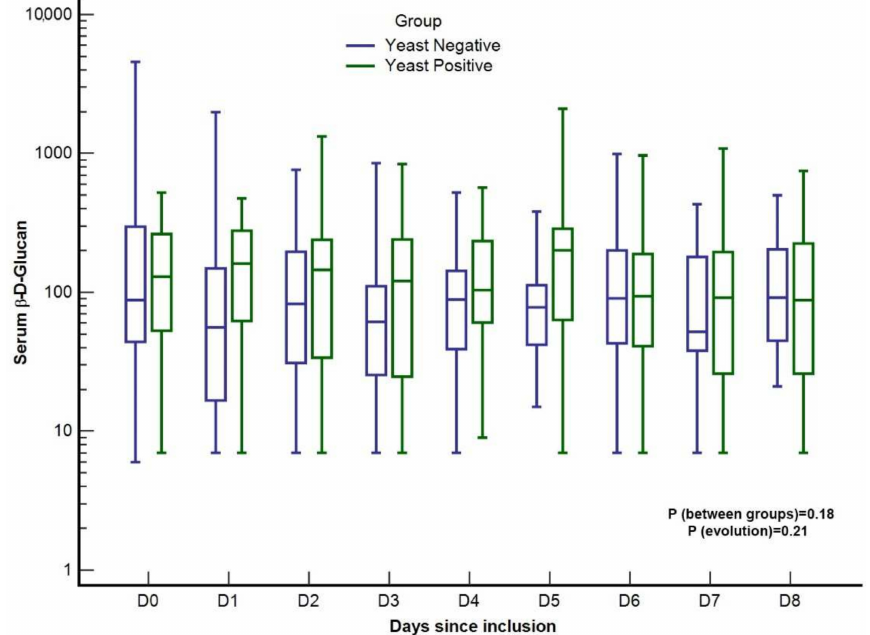
Figure 1. Time course of serum (1,3)-ß- D -glucan concentrations according to yeast positivity of peritoneal fluid in patients with complicated intra-abdominal infections. Values are in pg.mL − 1